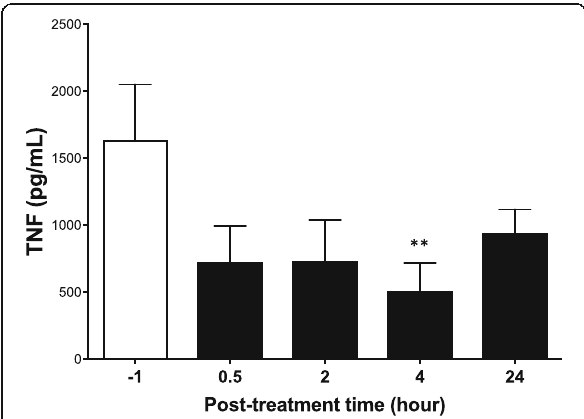
blood LPS-induced TNF production. In a pilot study, six healthy subjects were enrolled at the Academic Medical Center, the Netherlands, and subjected to vibrotactile stimulation at the cymba concha. Blood was obtained before stimulation ( − 1) and at different time points after stimulation (0.5, 2, 4 and 24h). Whole blood was incubated with LPS, and TNF levels in plasma were determined after 4h in culture. Data are shown as mean±SEM, ** p <0.01; RMANOVA with Friedman